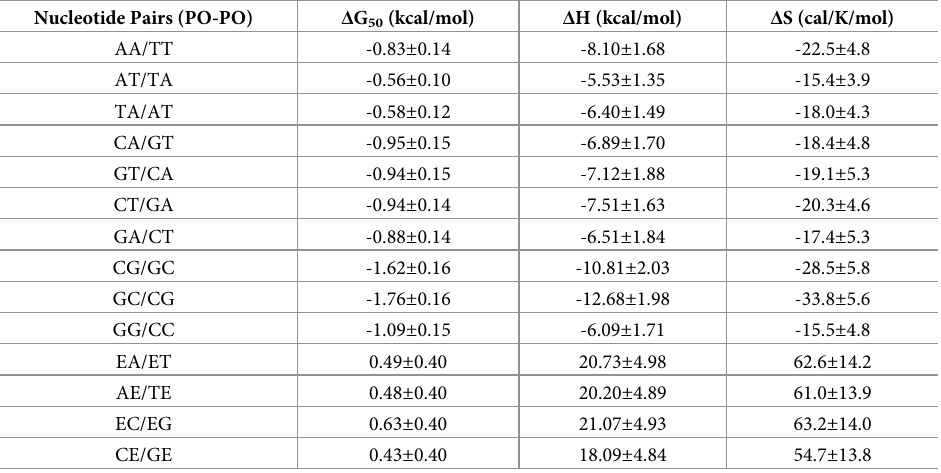
Table 1. Approximate thermodynamic parameters derived from HRM data.